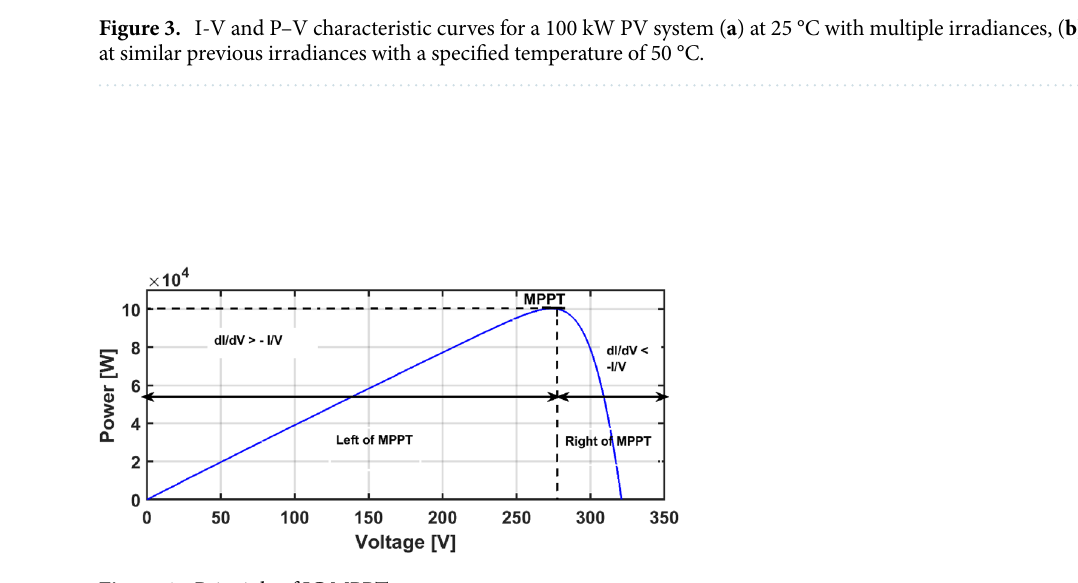
Figure 4. Principle of IC